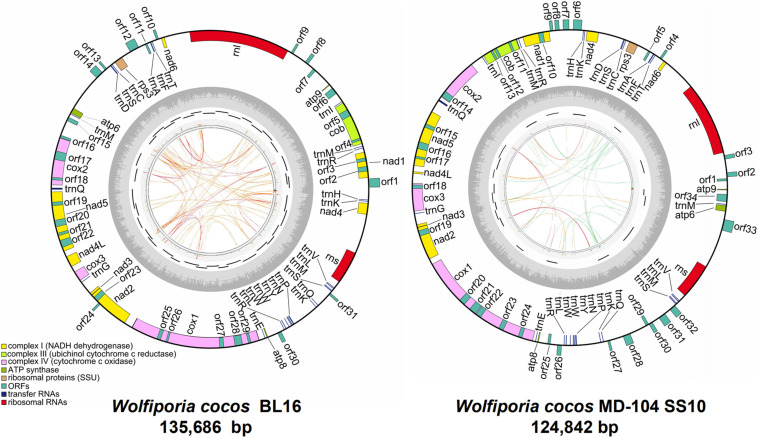
The ideogram of the two mitogenomes of Wolfiporia cocos. The outside ring with colorful blocks stands for mitochondrial ORFs, rRNAs, and tRNAs in W. cocos, and the blocks inside the ring stand for genes located on the J strand and the other side blocks stand for genes located on the N strand. The inside ring represents GC content. The inner side incomplete circle shows the PCR amplification regions. The innermost circle shows the repetitive sequences within mitogenomes, and the links of blue, green, orange, and red colors represent the score/max ratio, <0.25, <0.50, <0.75, and >0.75, respectively.